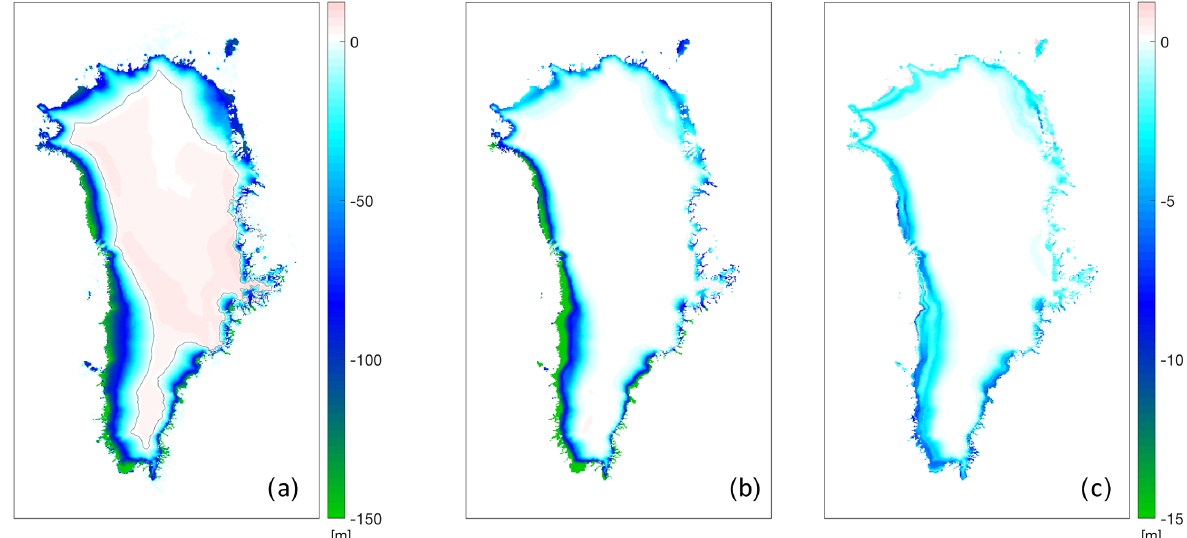
Figure 11. (a) Total elevation change between 2015 and 2100 due to local time integration of the aSMB with remapping to the evolving geometry. (b) Elevation change due to d(SMB) / d z(t) and (c) due to remapping only. The zero line in (a) is given as a grey contour. Note the different colour scale in (b) and (c) compared to (a) .